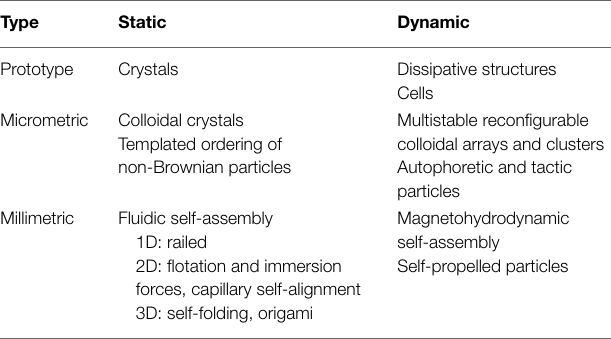
TABLE 1 | Representative instances of mesoscopic self-assembly in their static versus dynamic manifestations